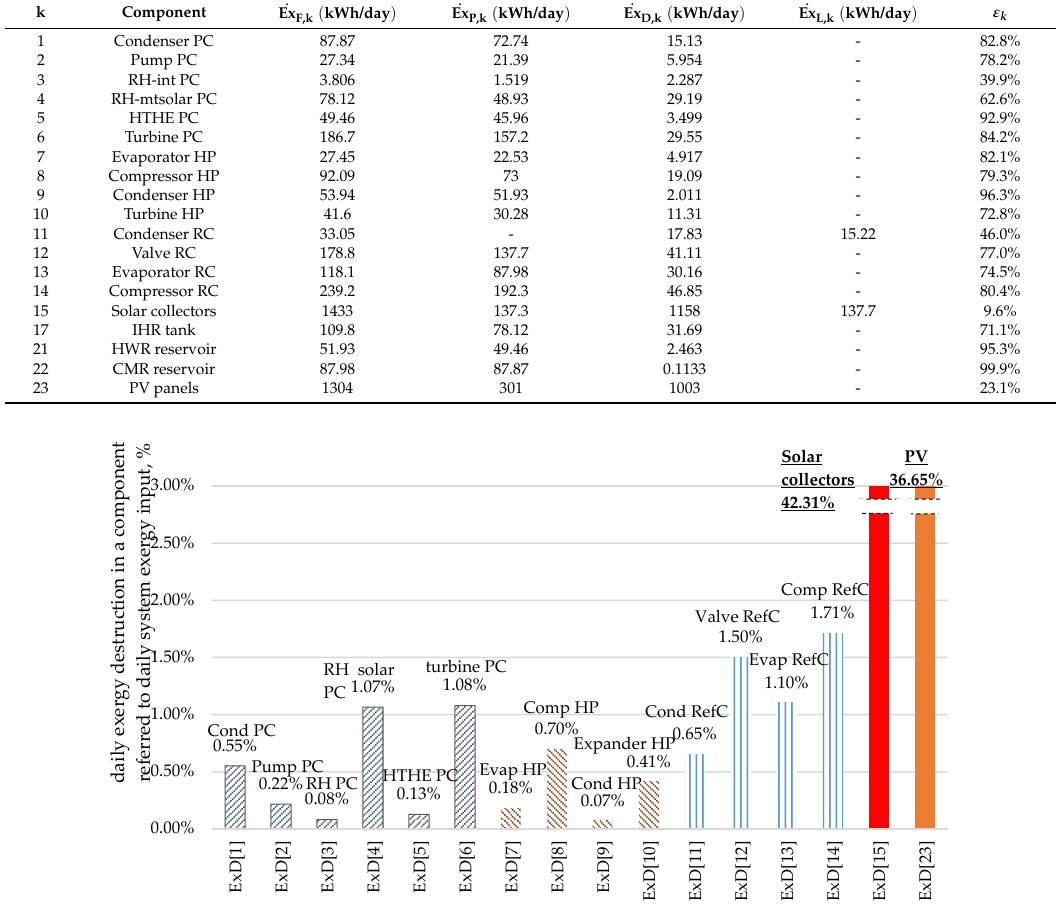
Table 8. Values of selected exergo-economic variables for system operating on reference day of May in Crotone.